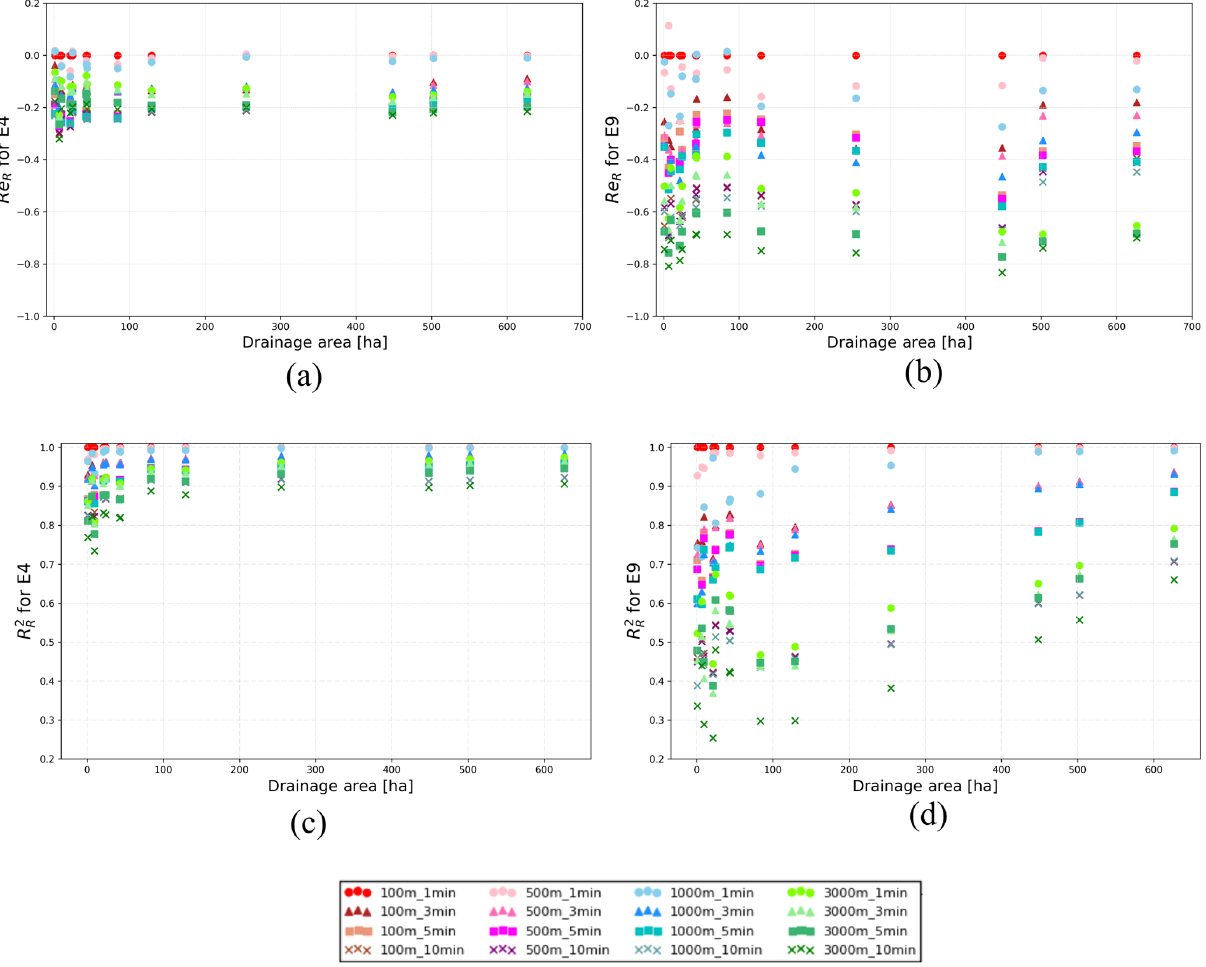
Figure 6. Impact of aggregation in space and time on rainfall peak ( Re R ) and overall pattern ( R 2 sub-catchment size ( A d ). E4 is a constant low-intensity event with low spatial variability. E9 is an example of an intermittent event, with a high storm motion velocity. Different colours and symbols indicate different rainfall resolutions used as input. Other events are presented in the